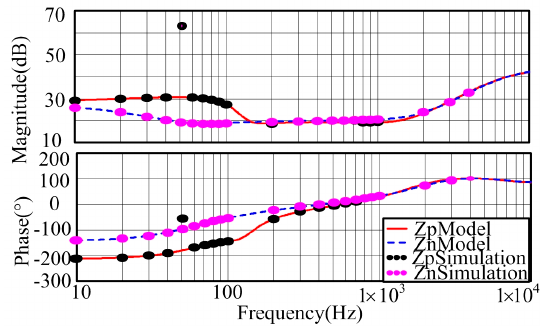
Figure 8. Impedance response with dq -domain IC control.